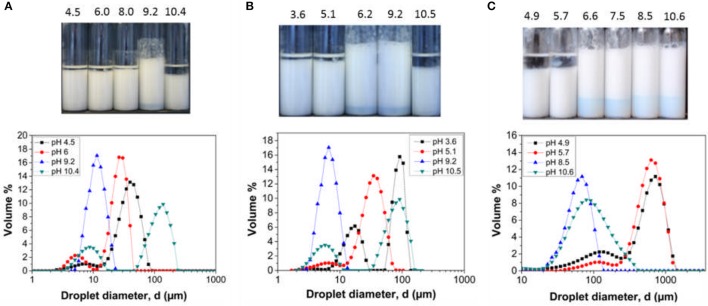
Digital images (top) and droplet size data (bottom) for hexadecane in water emulsions stabilized by (A) LP-DMAEMA54, and (B) LP-DMAEMA108, and (C) LP-DMAEMA245 as a function of pH in the presence of 0.01 M KNO3. Measurements were performed at 25°C.